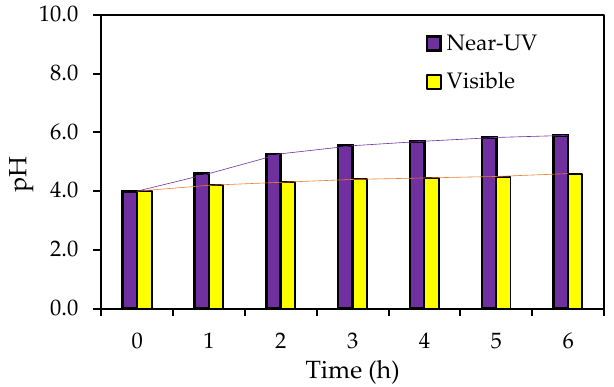
Figure 10. pH Changes with irradiation time using a 0.25 wt% Pd-TiO 2 -nUV and a 0.25 wt% Pd-TiO 2 -VIS .